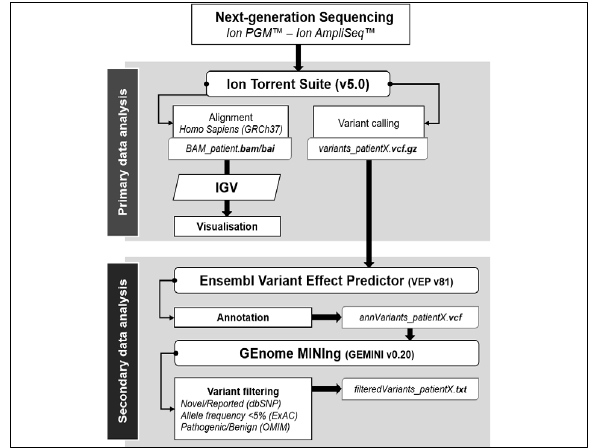
Figure 1: Next-generation sequencing bioinformatics pipeline followed for identifying disease-causing variants from Ion Torrent sequencing data. The first component of this illustration is primary data analysis, which is a semi-automated process done using the Ion Torrent Software (Torrent Suite). The second component illustrates software used for secondary data